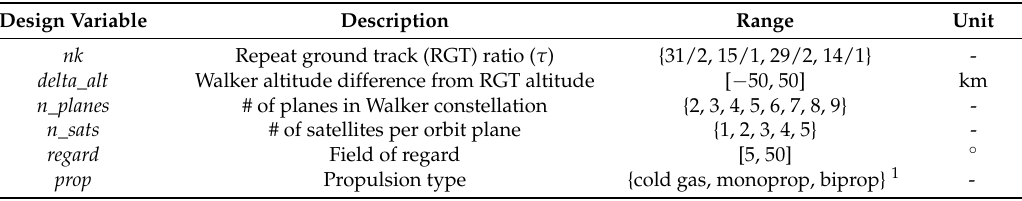
Table 2. Design variables in ReCon simulation.